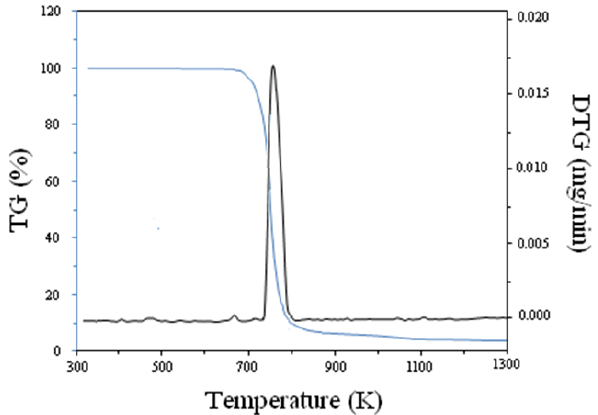
Figure 1. Thermal analyses of the polymeric precursor obtained by TG-DTG